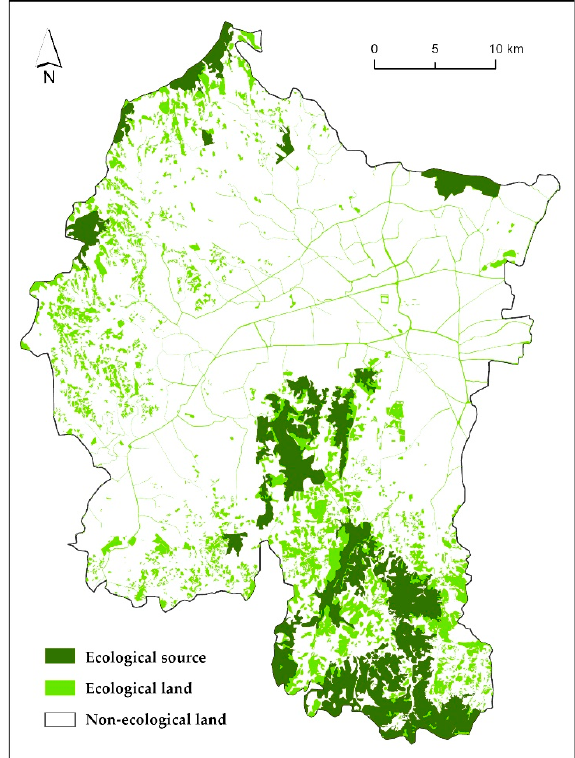
Figure 7. Distribution of ecological sources.